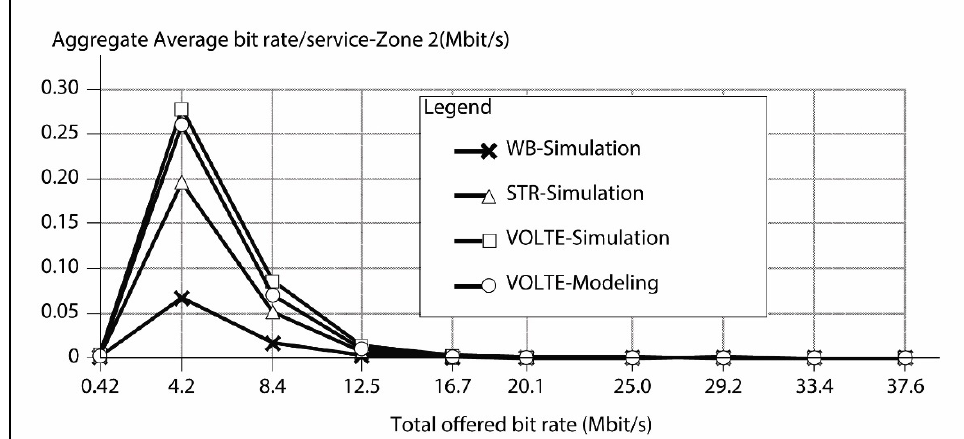
Figure 5. Zone 2: aggregate average bit rate.